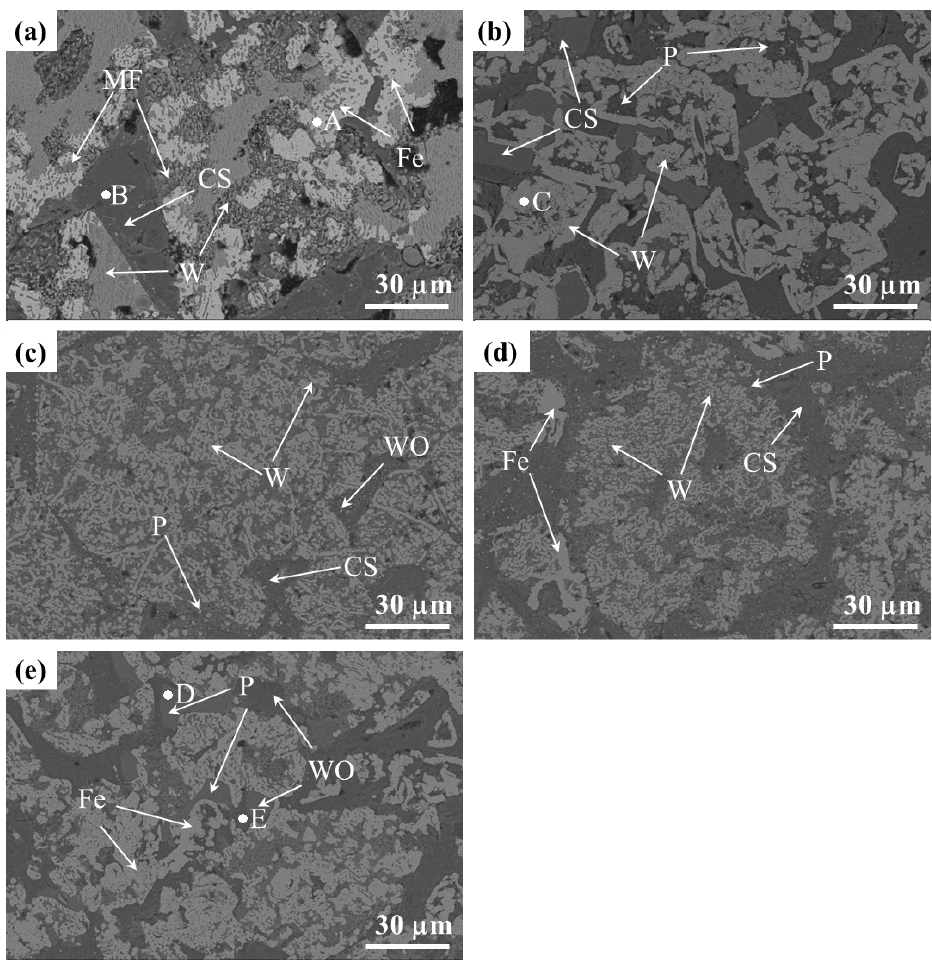
Figure 12. Backscattering detector (BSE) images of reductive CVTM sinter with different TiO 2 content. W: Wustite; MF: Magnesium Ferrite; CS: Calcium Silicate; P: Perovskite; WO: wollastonite. ( a ) TiO 2 = 5.85%; ( b ) TiO 2 = 7.35%; ( c ) TiO 2 = 8.85%; ( d ) TiO 2 = 10.35%; ( e ) TiO 2 = 11.85%.